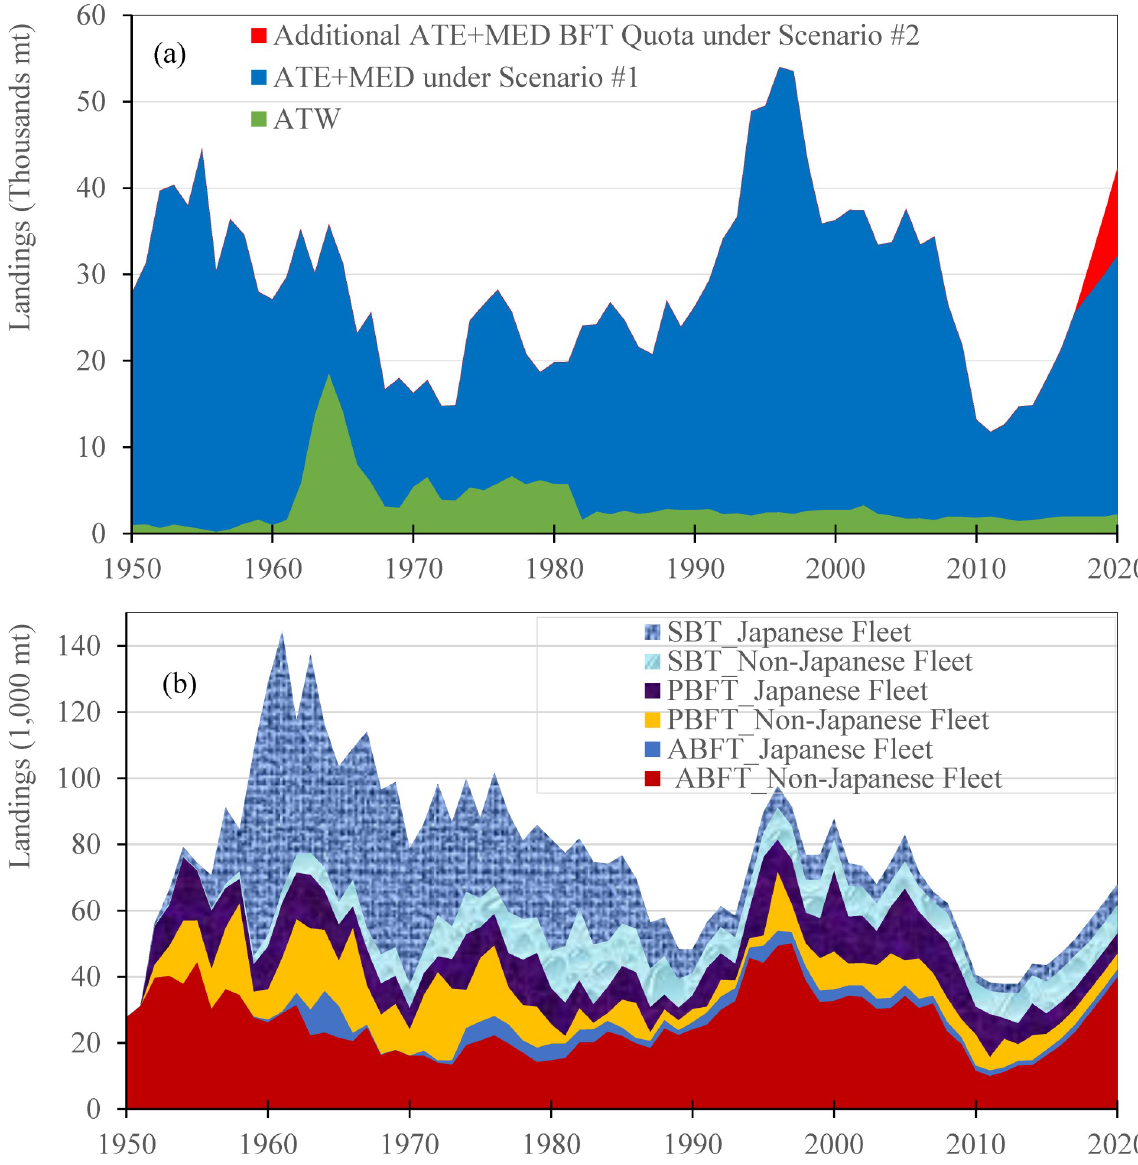
Fig 1. Cumulative annual supply of the bluefin tuna. (a) from Atlantic bluefin tuna by Stock Area (upper panel), with the abbreviation for Western Atlantic, Mediterranean, and Eastern Atlantic as ATW, MED, and ATE. (b) from global bluefin tuna by fishing Countries (lower